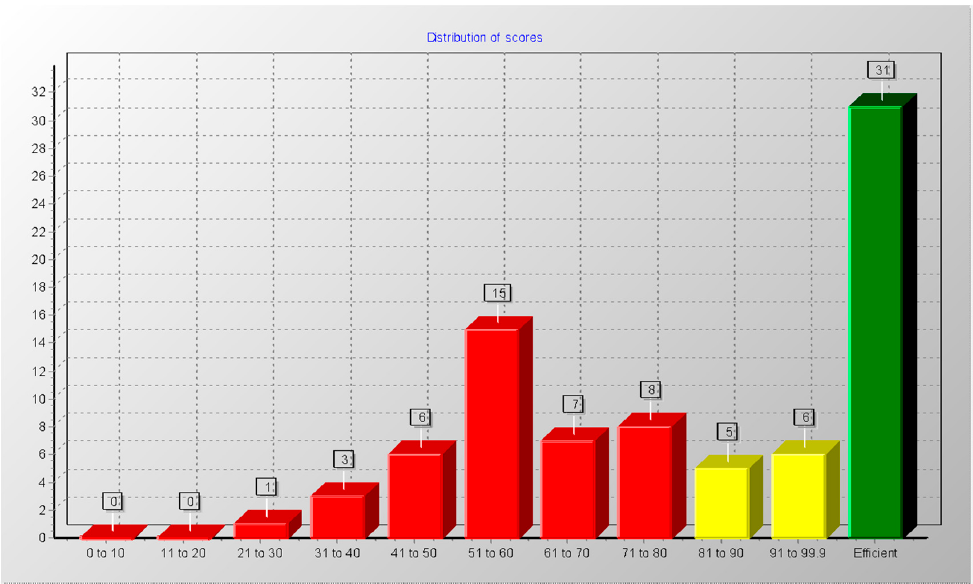
Figure 3. Maximum focused method score distribution with Banker, Charnes ve Cooper (BCC) Model.